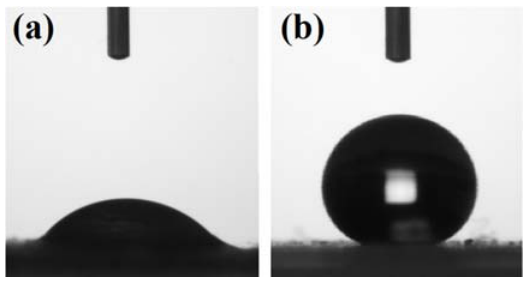
Figure 5. Contact angle of UES ( a ) and TES ( b ).